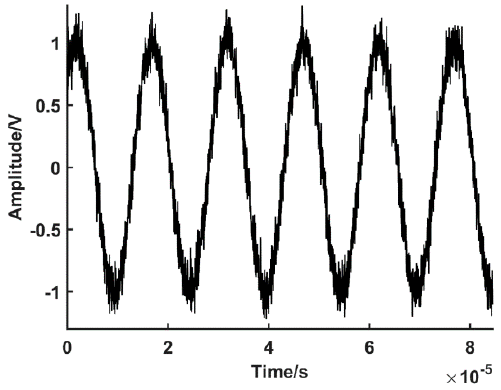
Figure 5. Sinusoidal signal acquired by high-speed data acquisition system (DAS).